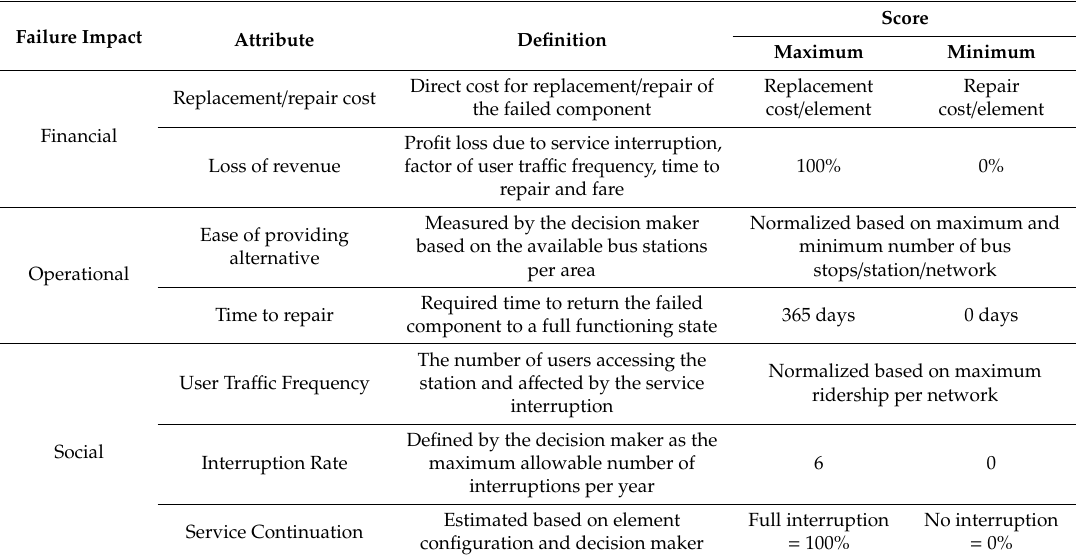
Table 3. Failure impacts Definition and Scales.